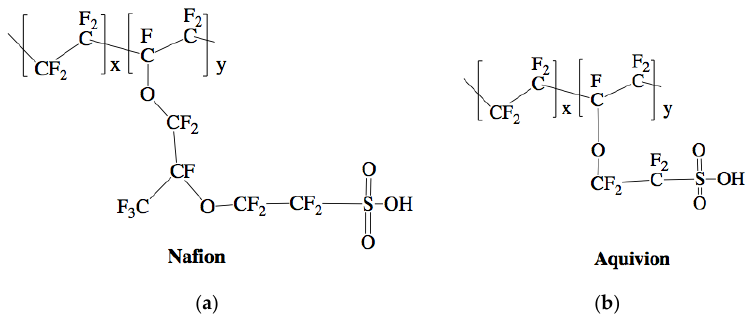
Figure 2. Chemical structure of Nafion ( a ) and Aquivion ( b ) activated, membrane forms [21,22].